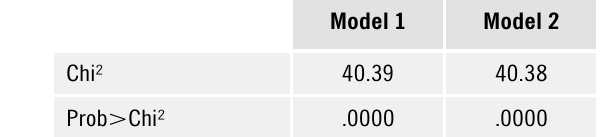
Shapiro-Wilks Statistic.